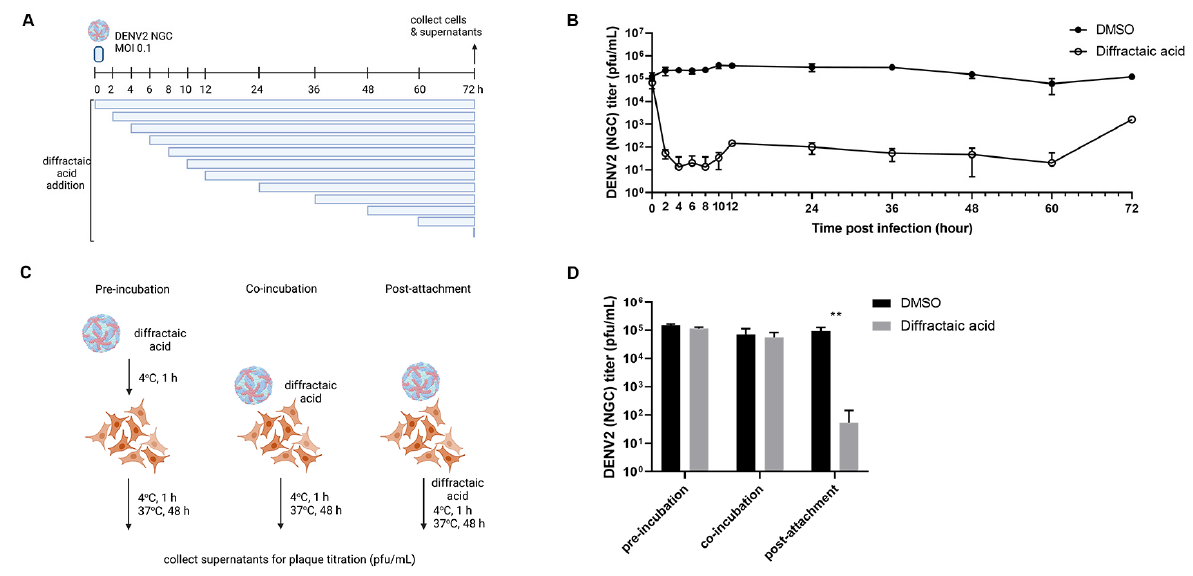
Figure 2. Time course study of diffractaic acid. ( A ) Schematic and ( B ) plaque titer results the time- of-addition assay. ( C ) Schematic and ( D ) plaque titer results of the anti-attachment assay. The DMSO-treated samples were used as no inhibition control; ** p < 0.01.